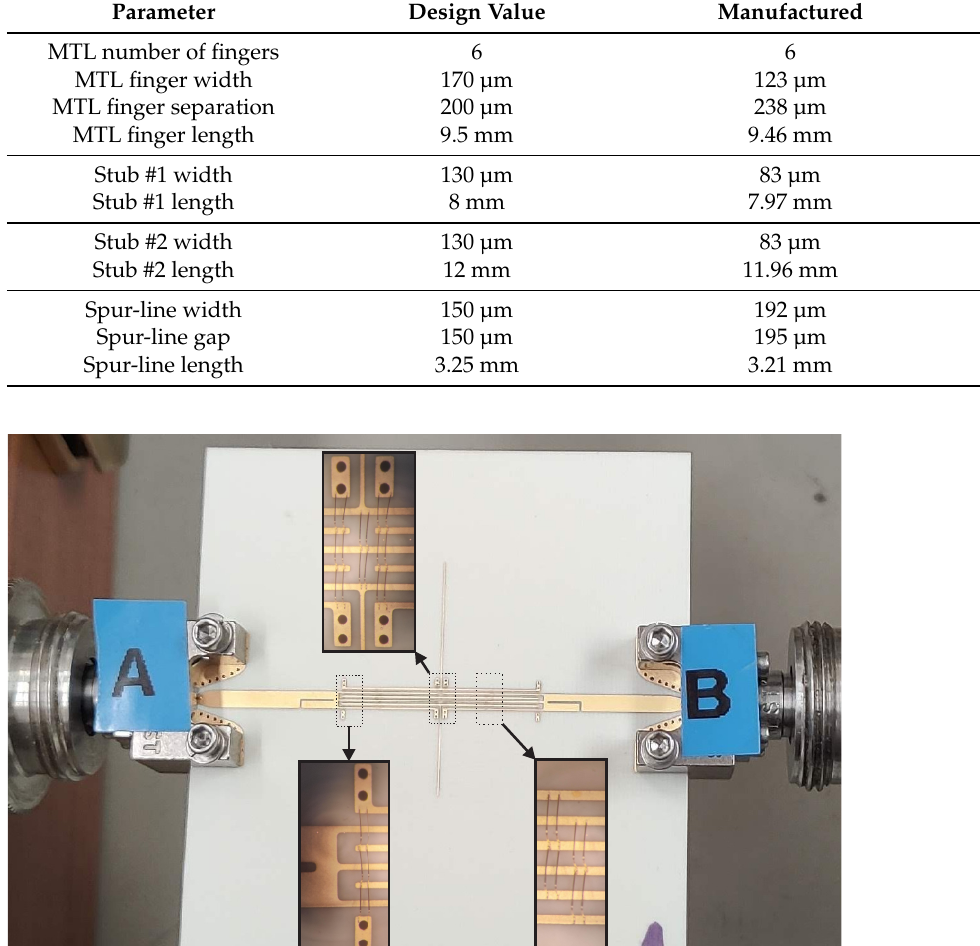
Table 1. Physical dimensions of the simulated filters.